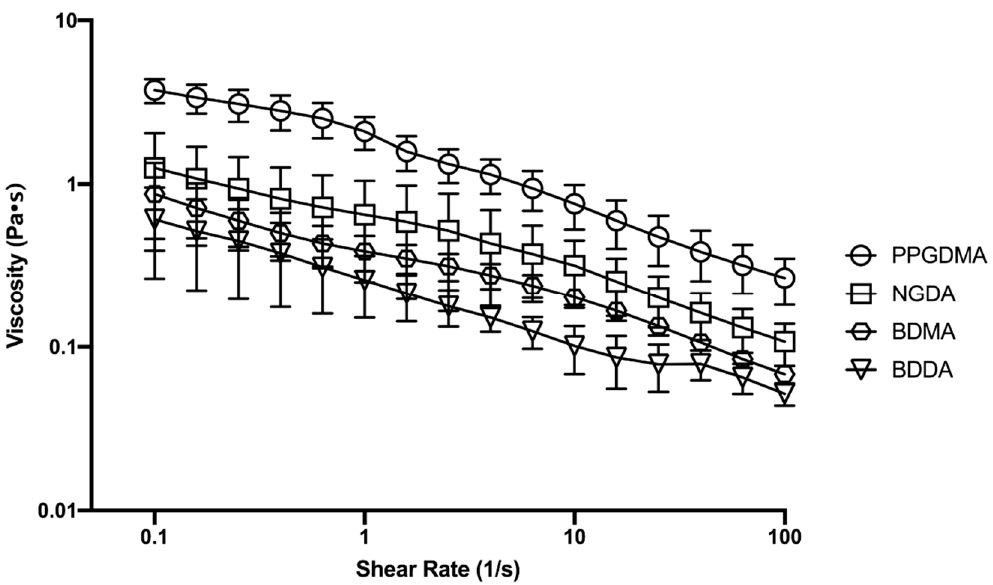
Figure 8. Log-log plot of relative viscosities of PPGDMA, NGDA, BDMA, and BDDA HIPEs at different shear rates. PPGDMA HIPEs maintained significant differences in viscosity ( p < 0.05) at all shear rates compared to NGDA, BDMA, and BDDA HIPEs.